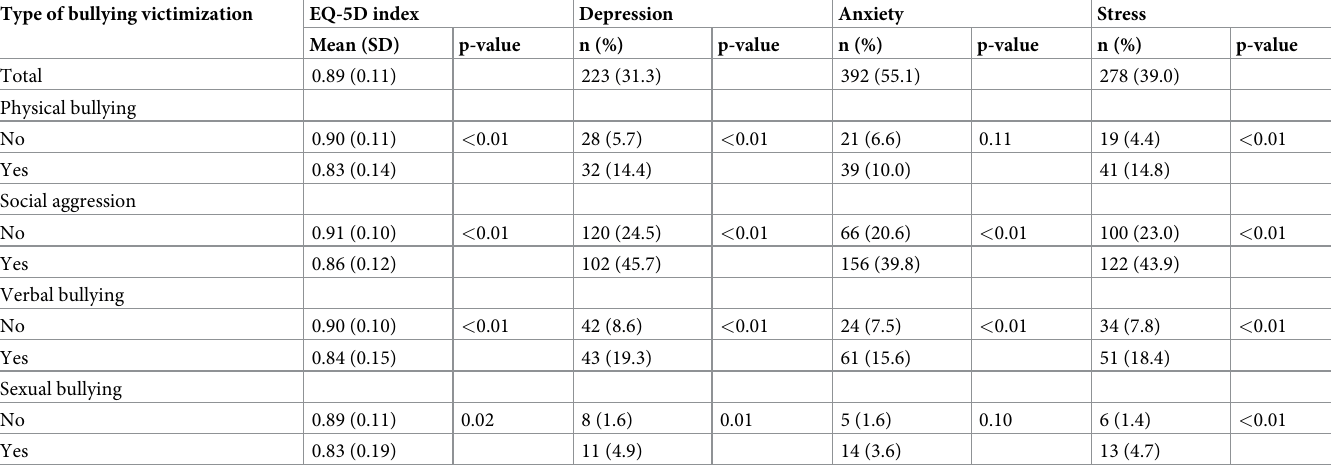
Table 5. Health-related quality of life and Depression, Anxiety and Stress regarding Types of Bullying victimization.